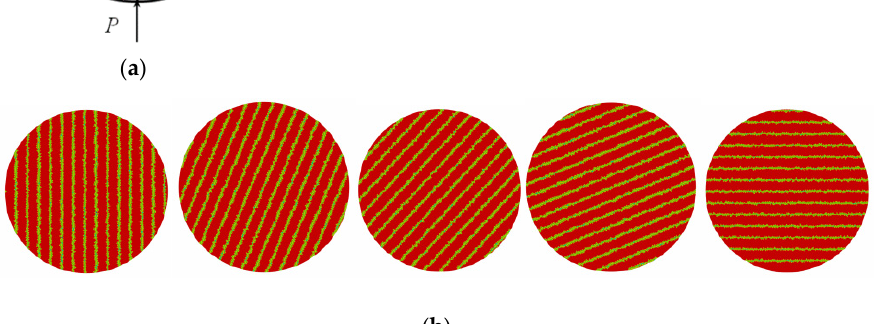
Figure 23. Numerical model of Brazilian disk coal specimen with different bedding angles. ( a ) The angle between the bedding plane and the loading direction is the bedding angle. ( b ) Models with bedding angles of 0°, 22.5°, 45°, 67.5° and 90° respectively. Table 3. Parameters of coal specimens involved in numerical calculation. Medium